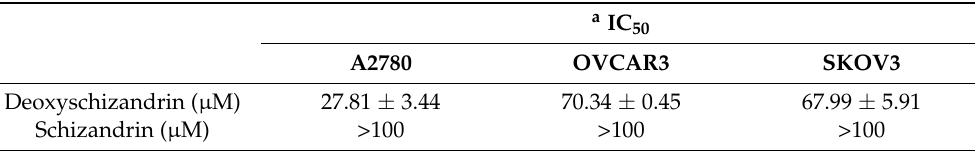
Table 1. Cytotoxic activity of deoxyschizandrin and schizandrin isolated from the berries of S. chinensis in human ovarian cancer cell lines.